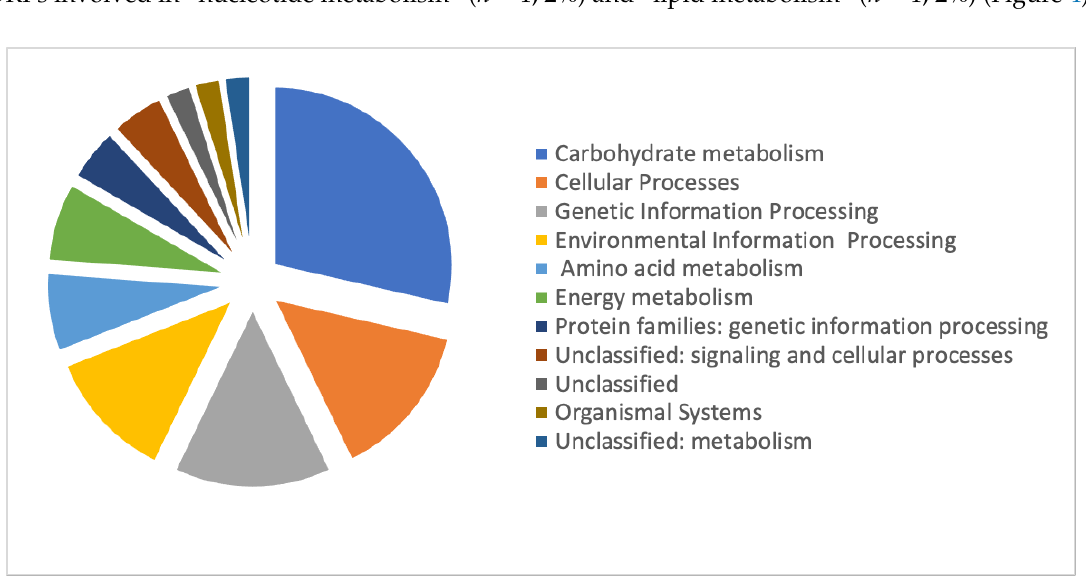
Figure 4. Representation of DRPs matching with a function in the Kyoto Encyclopedia of Genes and Genomes Pathway (KEGG) database. Each protein was classified in a KEGG